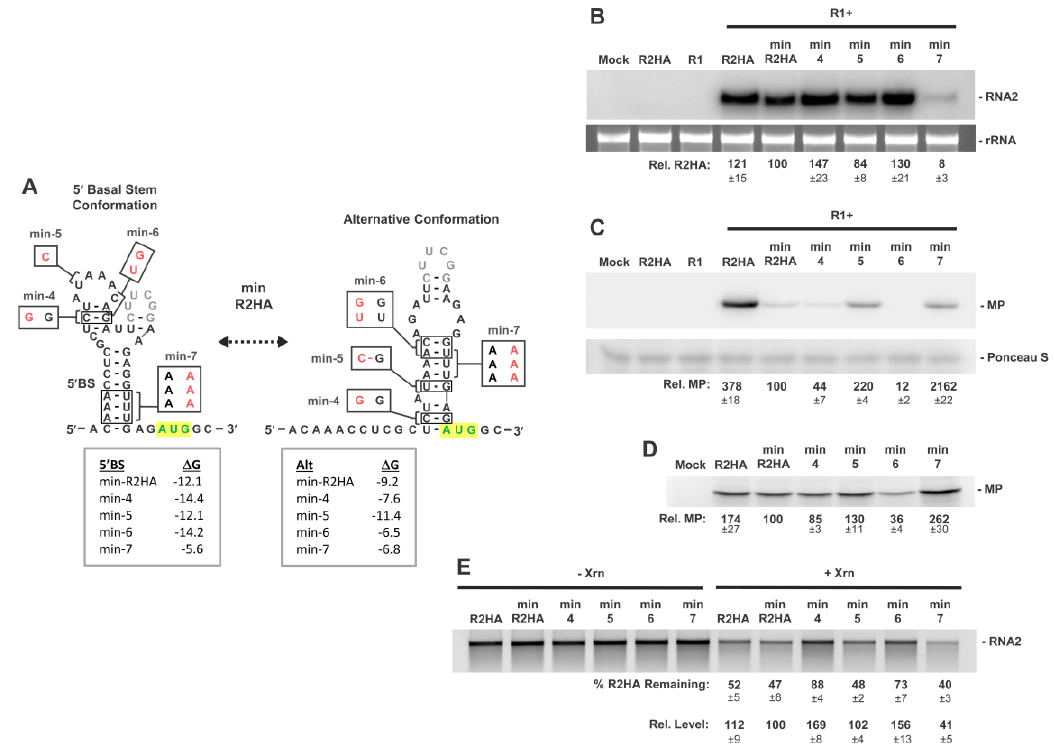
Figure 6. RNA2 minimal 5 ′ UTR mutants shifting conformational equilibrium. ( A ) RNA secondary structures for the two proposed conformations in the minimal 5 ′ UTR of min-R2HA. Substitutions designed to shift the equilibrium of the two conformations are shown in red on both conformations, with predicted free energy values below. ( B ) Northern blot analysis of protoplast infections of wt RNA1 (R1) and min-R2HA mutants. ( C ) Corresponding Western blot analysis of protoplast infections depicted in panel ( B ). ( D ) In vitro translation in wheat germ lysate of min-R2HA and mutants. ( E ) In vitro Xrn1 treatment of min-R2HA and mutants. Values generated as described in legend of Figure 3.